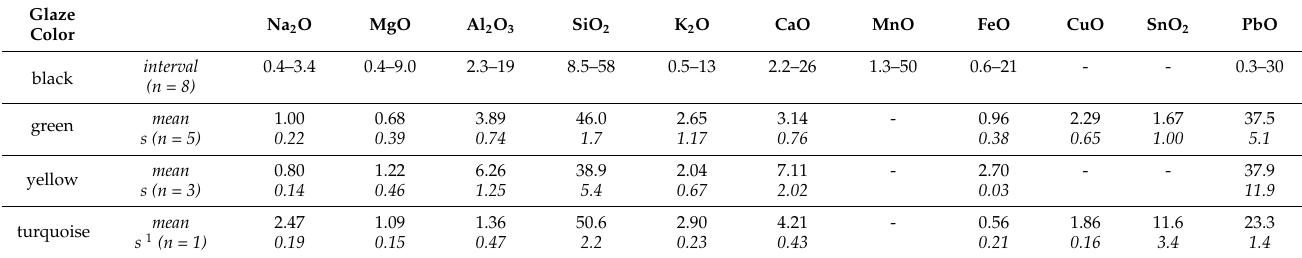
Table 5. Chemical composition (%wt) of the black line, yellow and green glazes in cuerda-seca decorated ceramics by EDS.